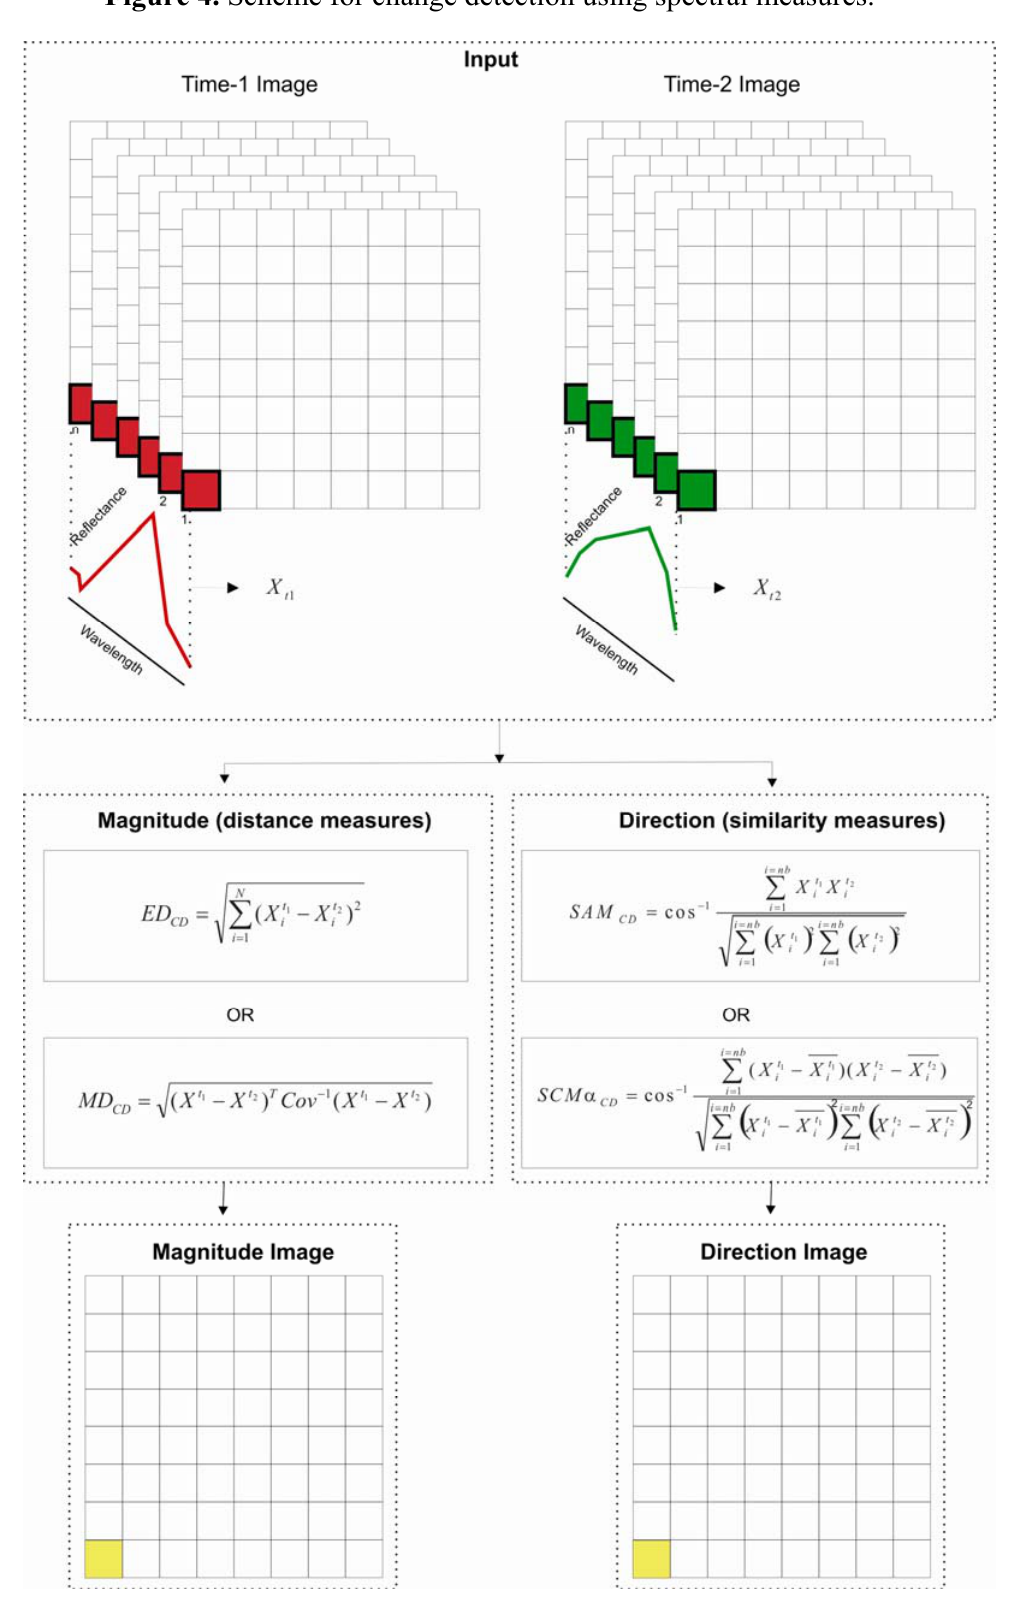
Figure 4. Scheme for change detection using spectral